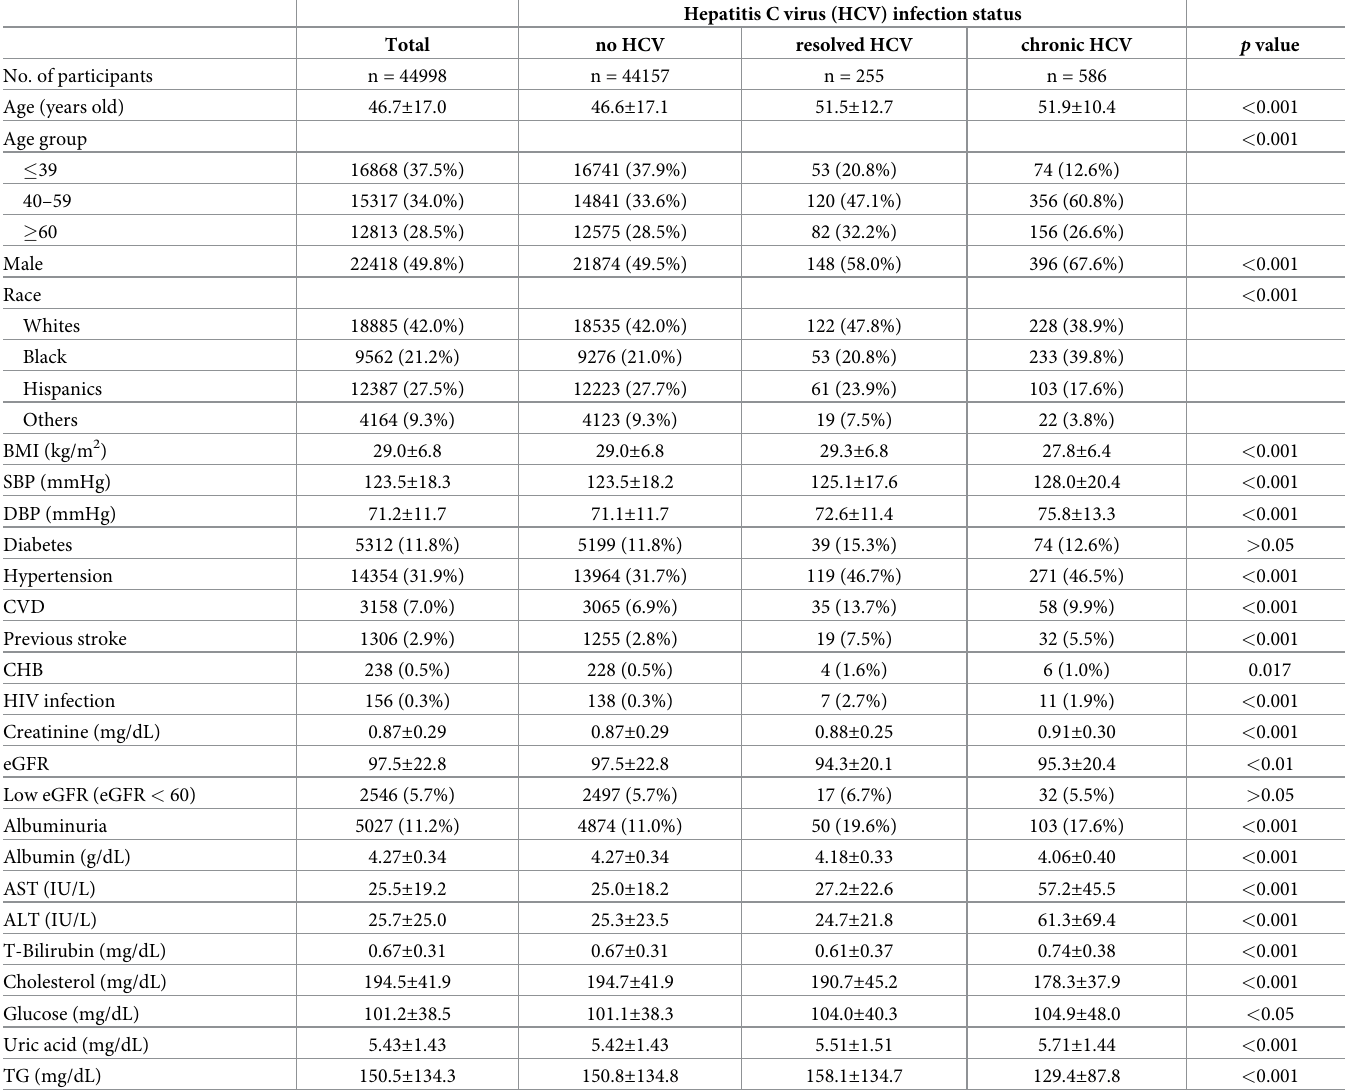
Table 1. Characteristics of study participants by hepatitis C virus (HCV) infection status.